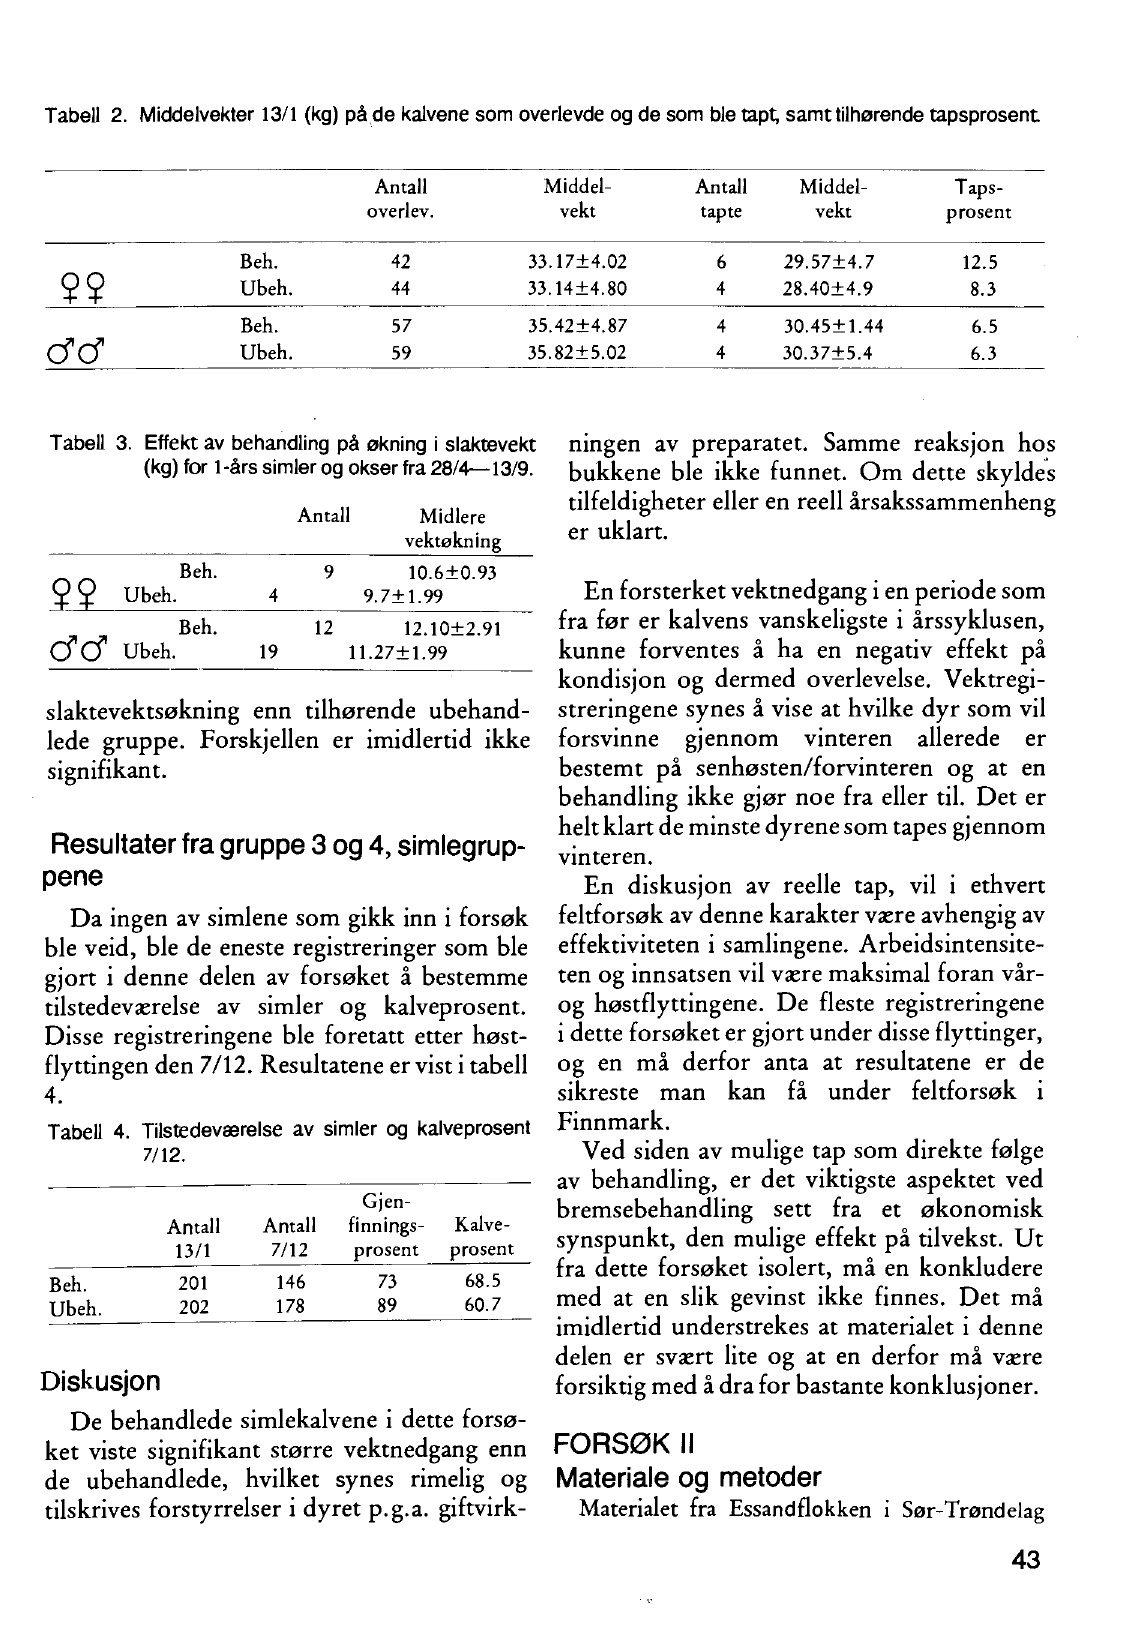
Antall Middel Antall Middel Taps overlev. vekt tapte vekt prosent